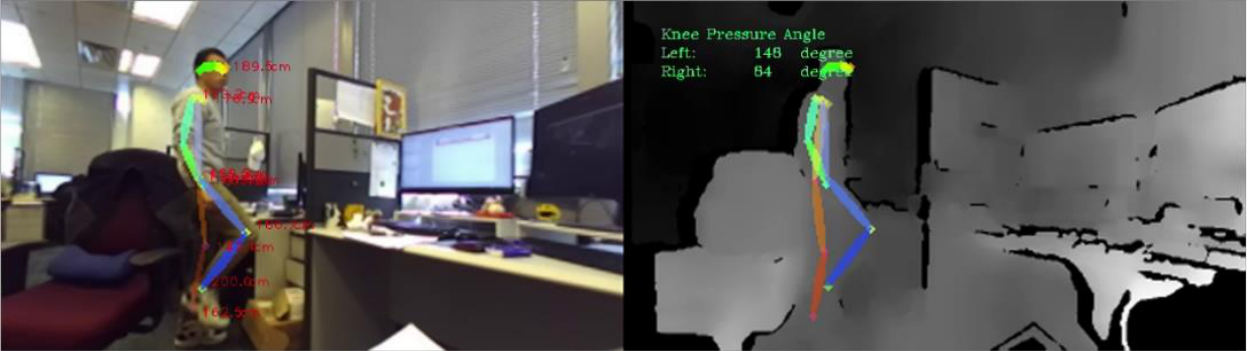
Figure 6. Experimental result and visualisation of all the information stored in the queue